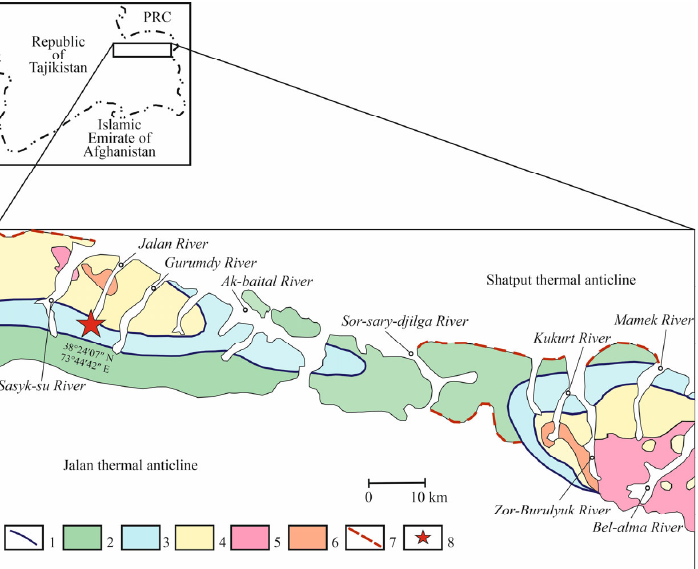
Figure 1. Schematic map of the metamorphic zoning of the Muzkol metamorphic complex. 1—boundaries of metamorphic facies; 2—greenschist facies (zones 3 and 4); 3—epidote-amphibolite facies (zone 2); 4—amphibolite facies (zone 1); 5—Neogene granites and syenites; 6—Early Paleozoic gneiss-granites; 7—boundaries of tectonic nappes; 8—sampling site (Jalan-3) [103], with additions by the